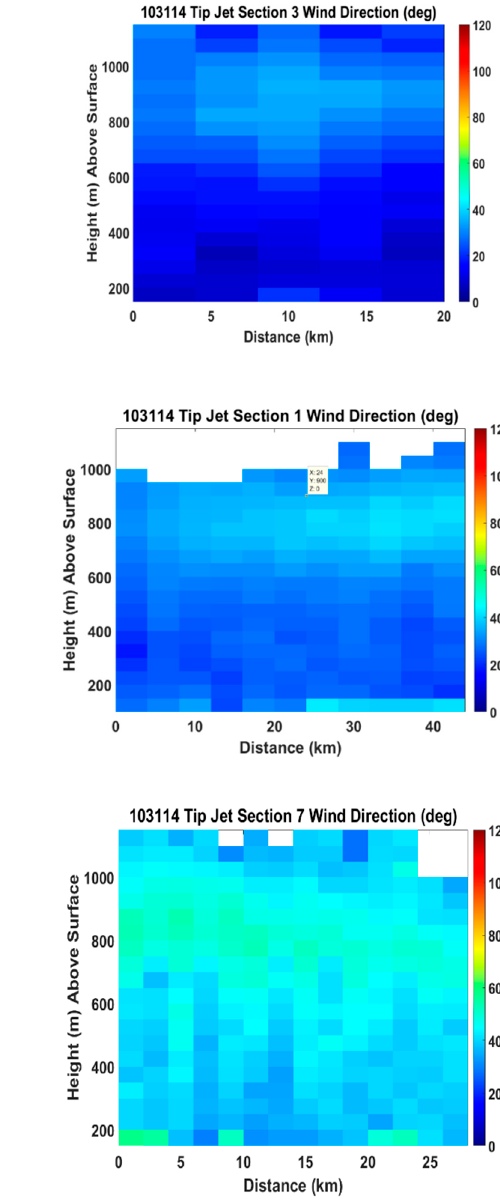
Figure 16. x–z cross section of DAWN wind speed ( left ) and direction ( right ) along the NW–SE oriented legs from 3—east of the tip ( top ) to 1—south of the tip ( middle ) and 7—south of Cape Farewell ( bottom ) on 31 October 2014.